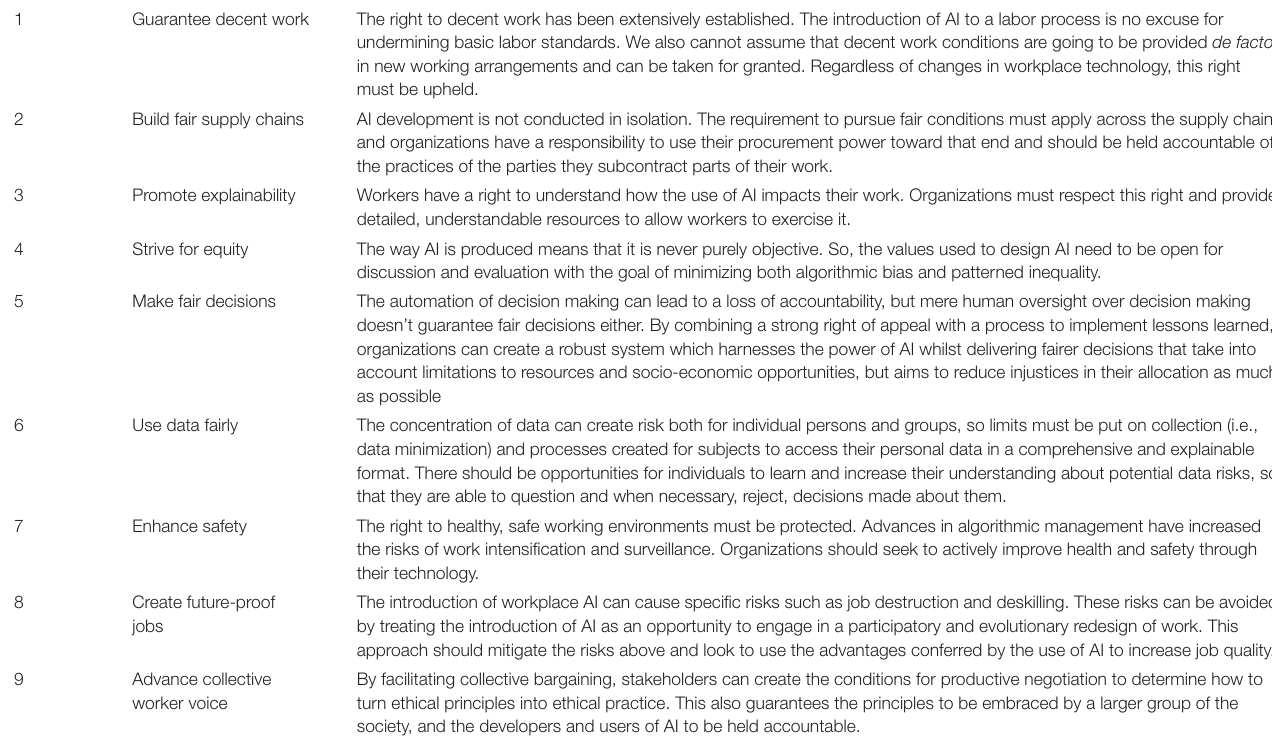
TABLE 2 | Nine draft principles for the GPAI’s “Fair Work for AI”